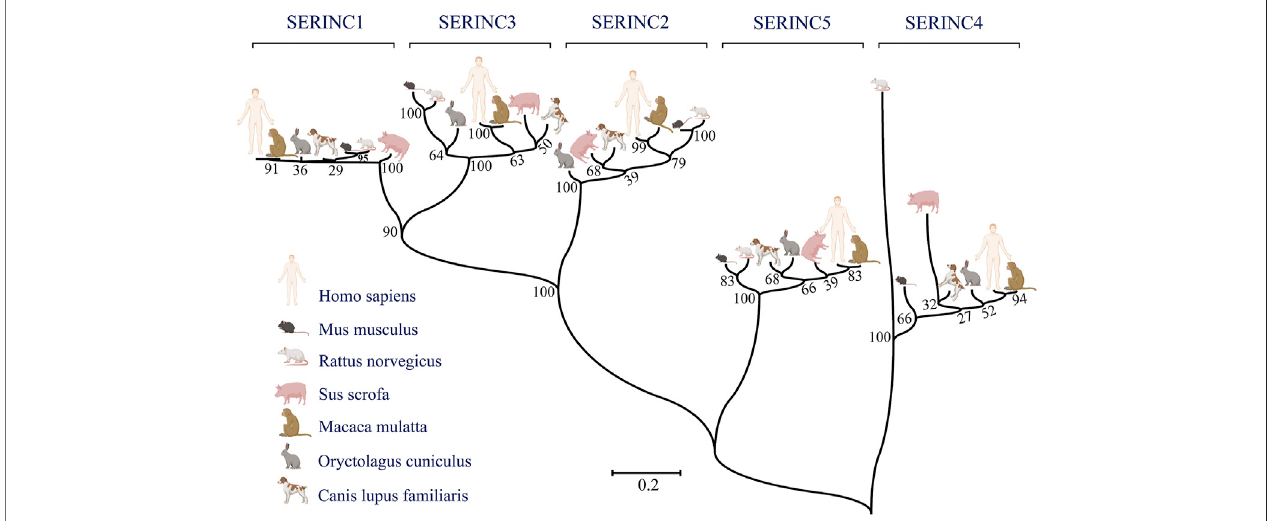
FIGURE 1 | The phylogenetic relationships between humans and other commonly used experimental animals are depicted using MEGA7 software. Maximum likelihood was chosen as the statistical method. The bootstrap value was set to 1,000 gaps/missing data treatment is complete deletion. (Created by Biorender.com).